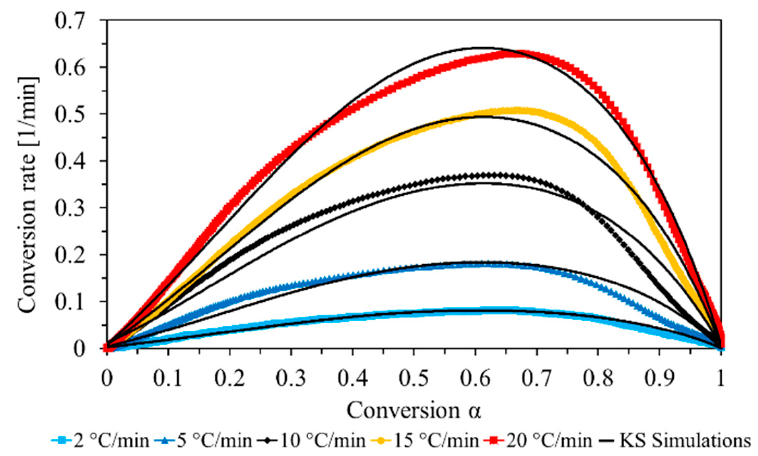
Figure 3. Conversion rate plotted against the conversion α for the experimental data and simulation fits. Table 2. Kinetic parameters determined using the Kamal-Sourour model based on DSC data. Kinetic Parameters